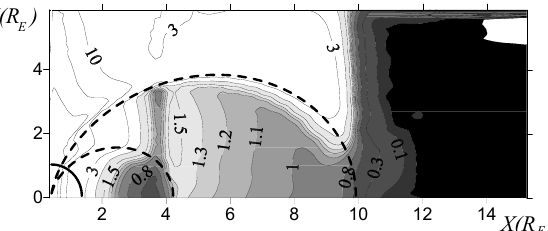
Fig. 3. The Alfv´en velocity (10 3 km/s) isolines in the magnetic meridian plane in the magnetospheric model under study. The dashed lines indicate the plasmapause ( L = 4) and magnetopause ( L =